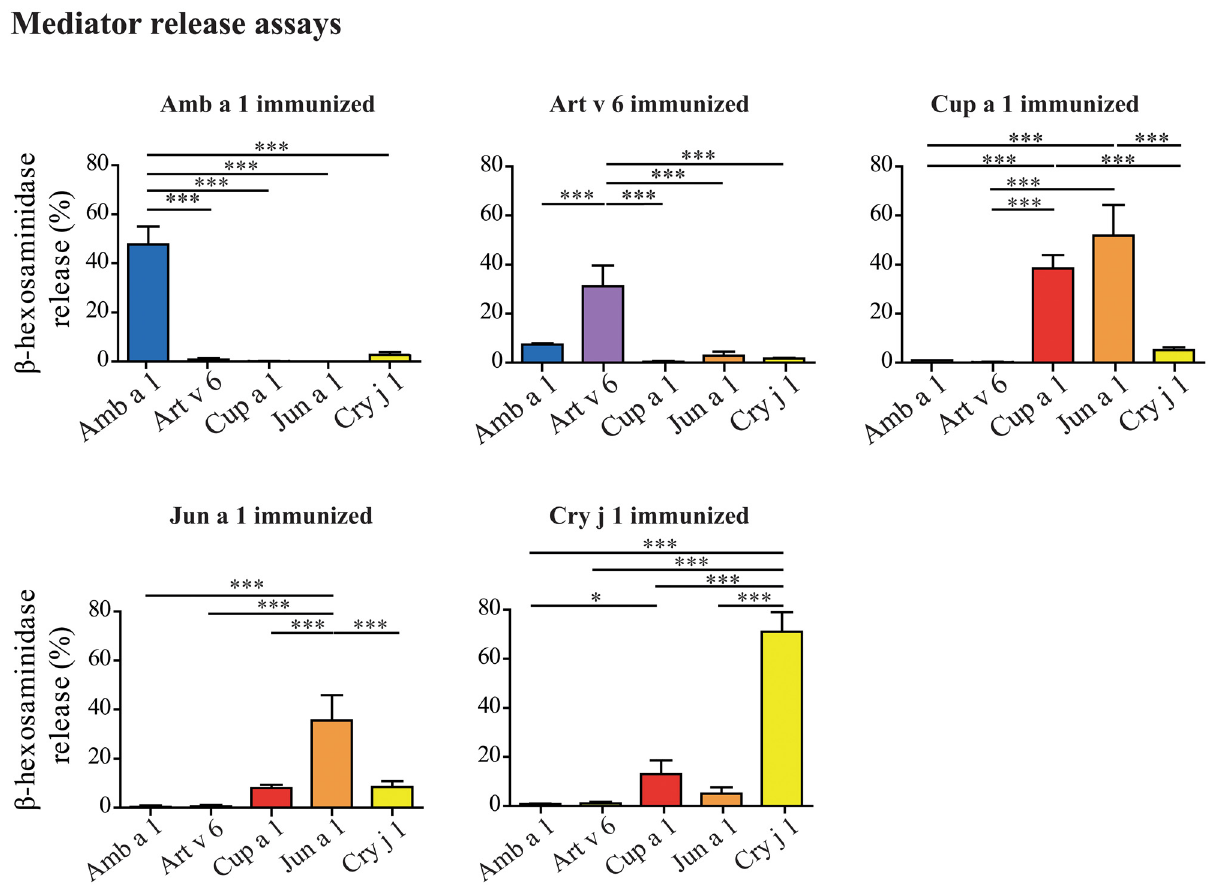
Fig 7. Biologically functional IgE of immunized mice was analyzed by mediator release assays. RBL-2H3 cells were passively sensitized with pooled immune sera (n = 5 animals/ group) withdrawn at day 49, and mediator release was triggered by addition of 0.3 μ g/ml allergen. Relative β -hexosaminidase activity was calculated compared to Triton X-100 treated cells. Results are presented as mean of duplicates ± SEM. Statistical analysis was performed with One-way ANOVA and Tukey´s Multiple Comparison Test ( * P < .05, ** P < .01, *** P < .001).